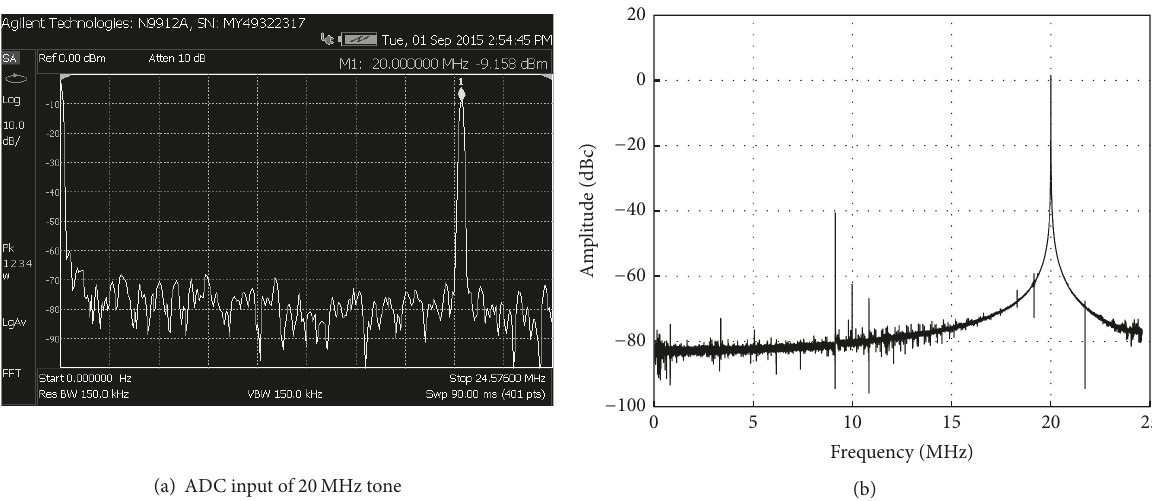
Figure 20: 20 MHz tone ADC output streamed using UDP. (a) ADC input of 20 MHz tone generated with function generator, (b) FFT for 20 MHz ADC signal captured on a PC after streaming.